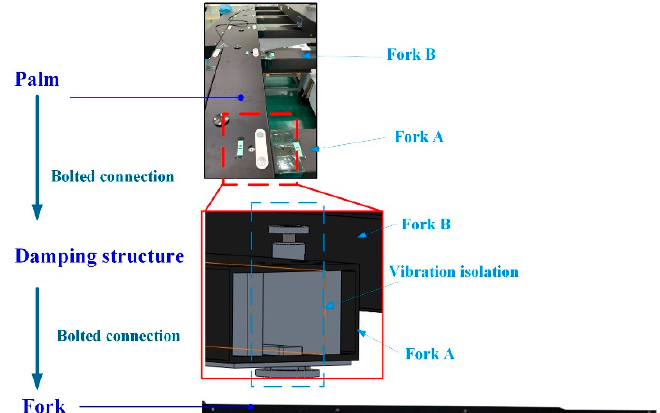
Figure 3. The details of the connection.